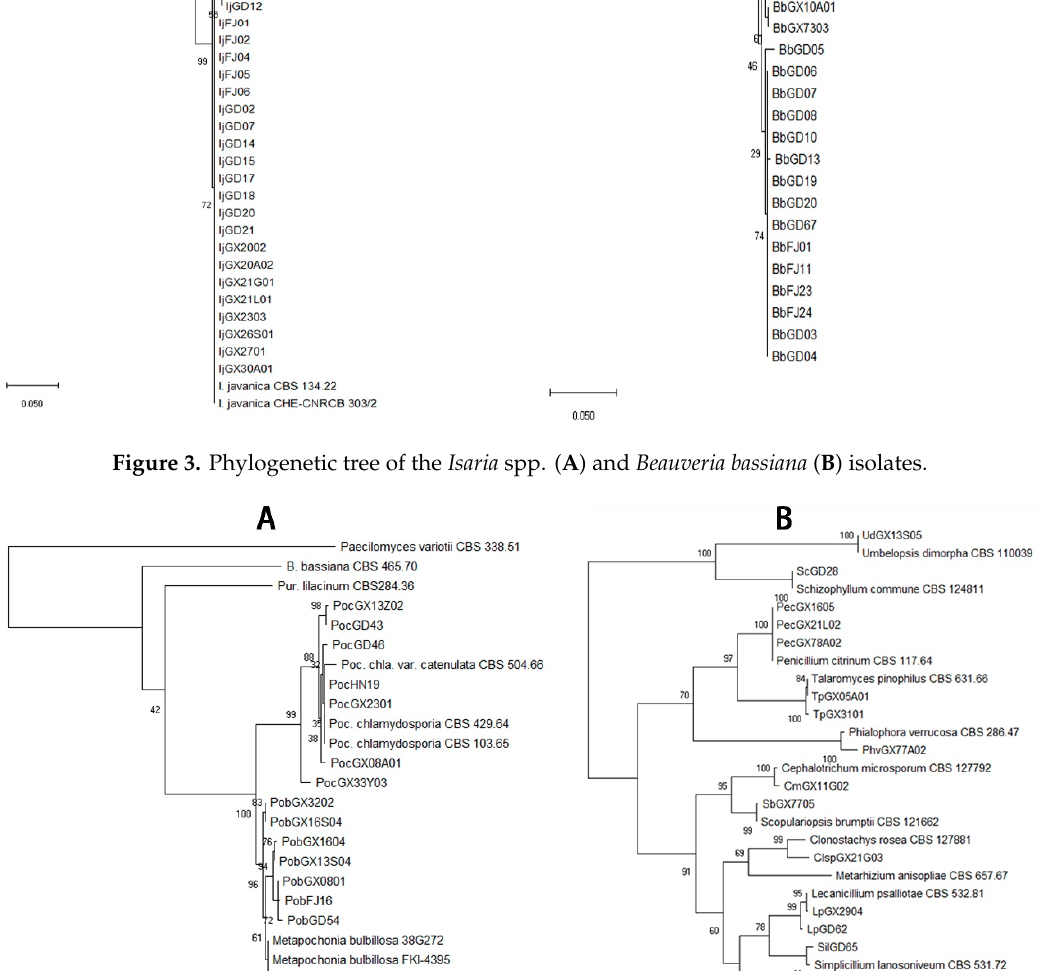
Table 2. The fungi isolation and biodiversity of different regions.